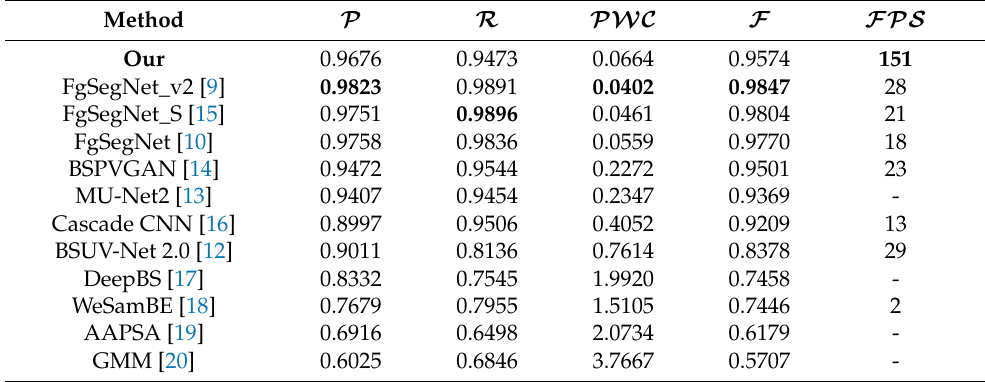
Table 8. Quantitative results of existing state-of-the-art methods on the CDNet2014 [47] benchmark. The inference speed is calculated from the input video with a resolution of 320 × 240. The best results are marked in